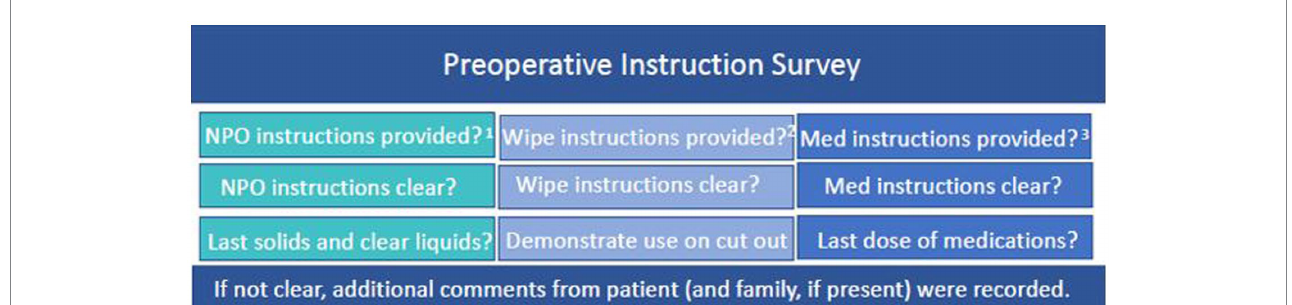
FIGURE 1 Preoperative Instruction Survey Questions. 1 NPO instructions: no solid food within 8 h of scheduled surgical time, drink 16oz. of water at least 2 h prior to scheduled surgery time. 2 CHG wipe instructions: handout was reviewed in clinic and provided to take home. 3 Medication instructions included in this study: antihypertensives, blood thinners and diabetic